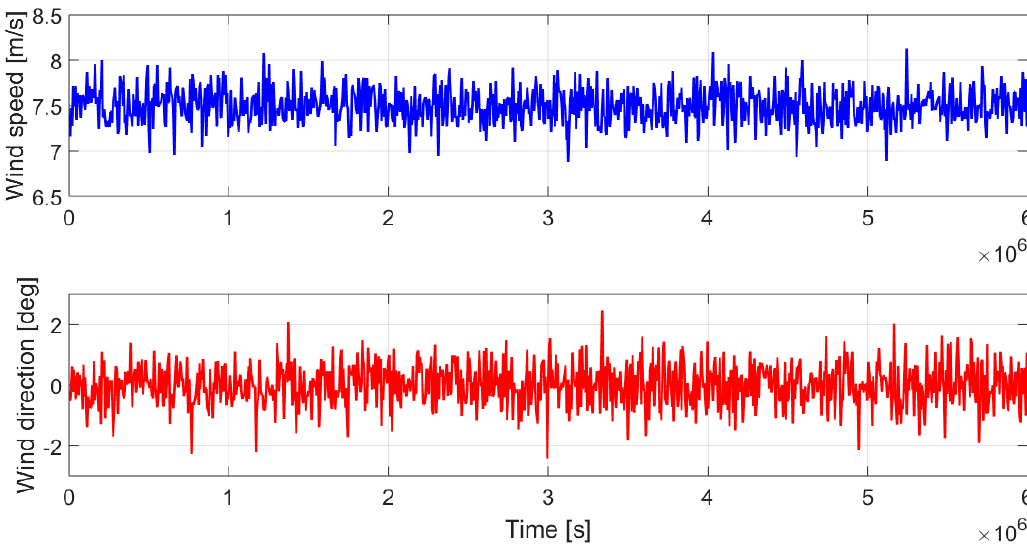
Figure 4. Wind data series generated with TurbSim tool. Table 1. Parameters of the wind data series generation process in